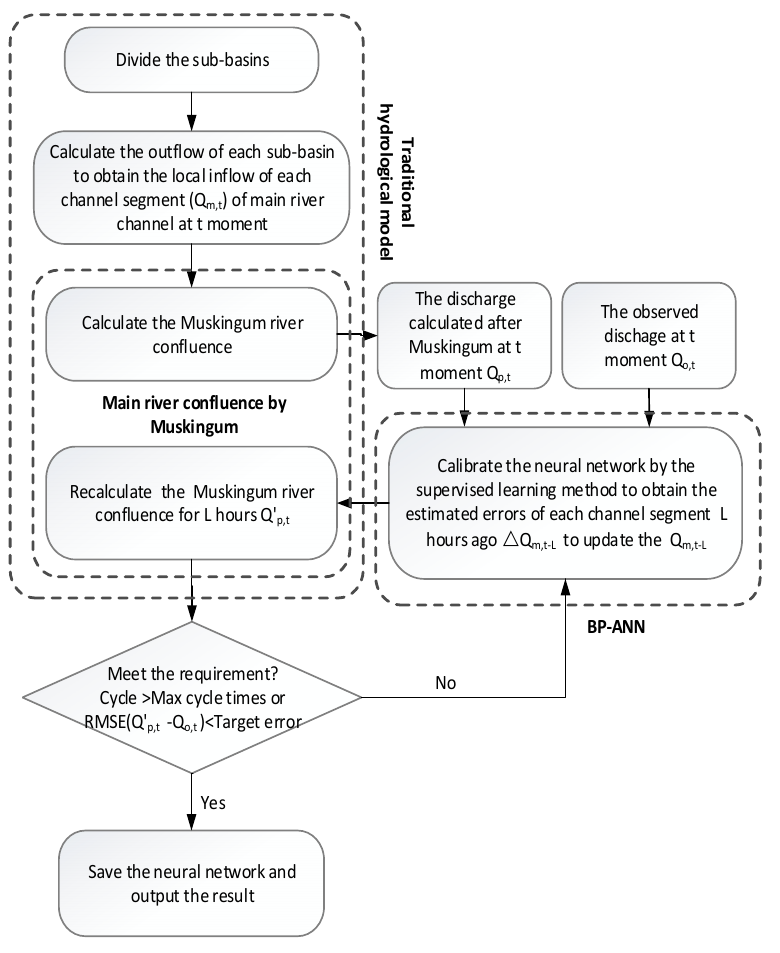
Figure 3 . The flowchart of the BPC algorithm applied to the traditional hydrological model. Figure 3. The flowchart of the BPC algorithm applied to the traditional hydrological